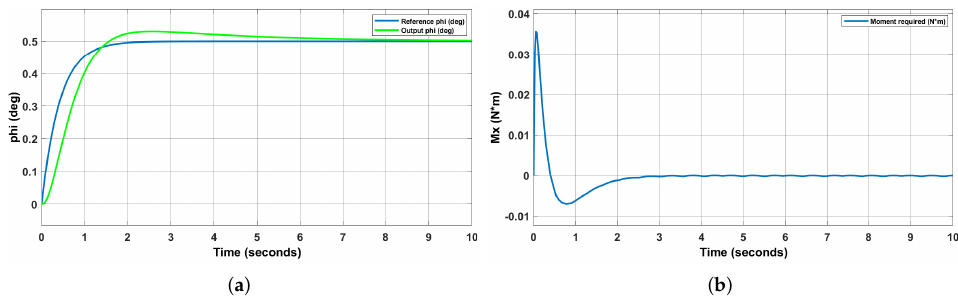
Figure 19. Response for φ transfer function: ( a ) φ response; ( b ) moment